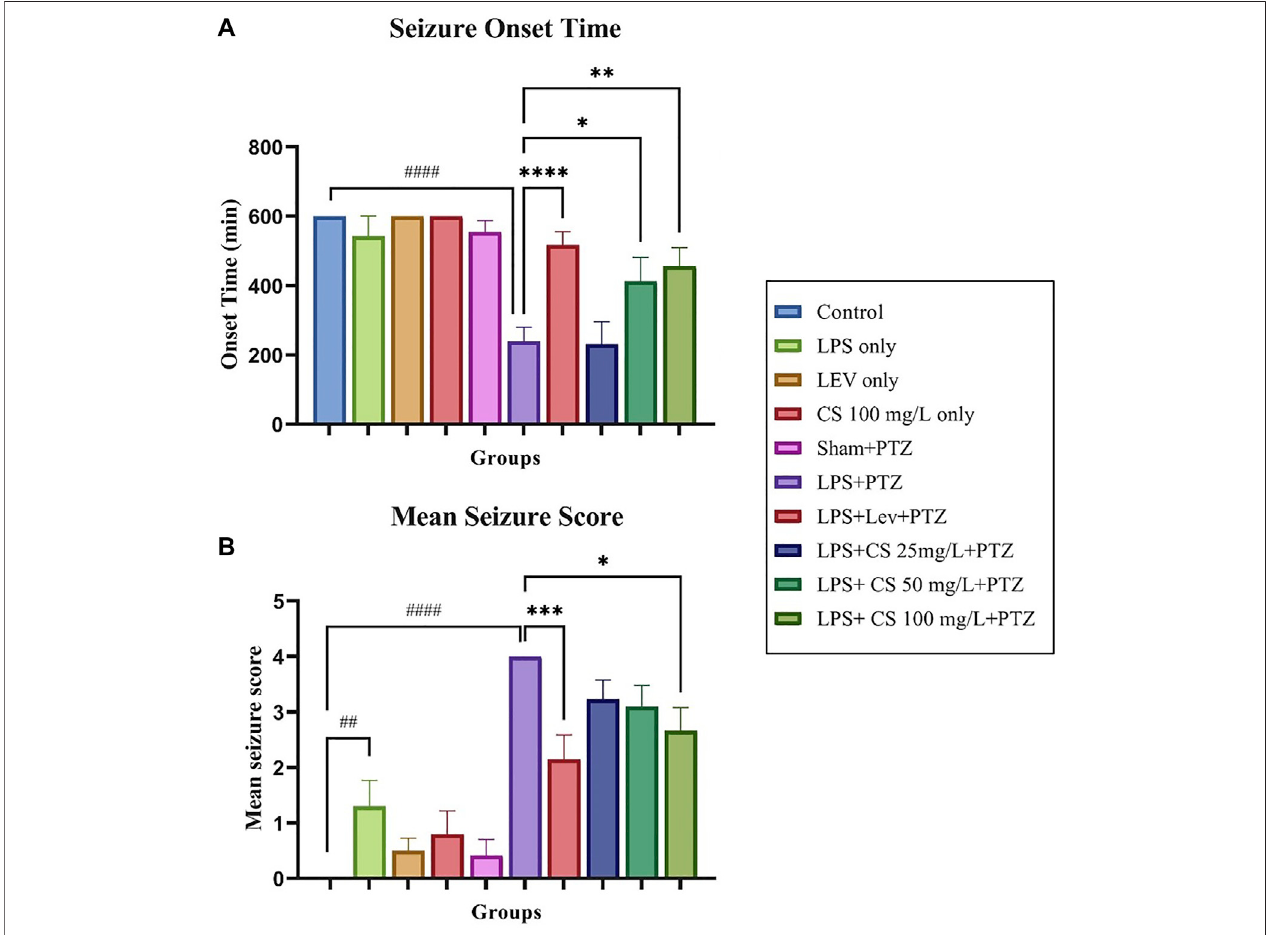
FIGURE2 |(A) Seizure score4 onset time for each group. (B) Meanseizure scores for each group. The p -values **** p < 0.0001, *** p < 0.001, ** p < 0.01, and * p < 0.05 were regarded as statistically signi fi cant for the treatment groups compared to the negative control (LPS + PTZ). The p -values #### p < 0.0001, ### p < 0.001, ## p < 0.01 and # p < 0.05 was regarded as statistically signi fi cant for the per se groups compared to the control.